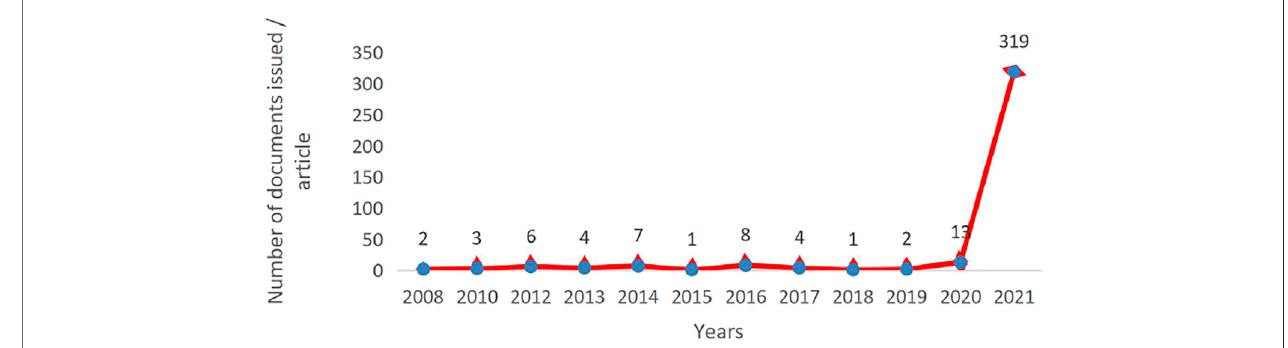
FIGURE 2 | Statistics on the number of publications in China ’ s carbon neutral fi eld from 2008 to 2021.